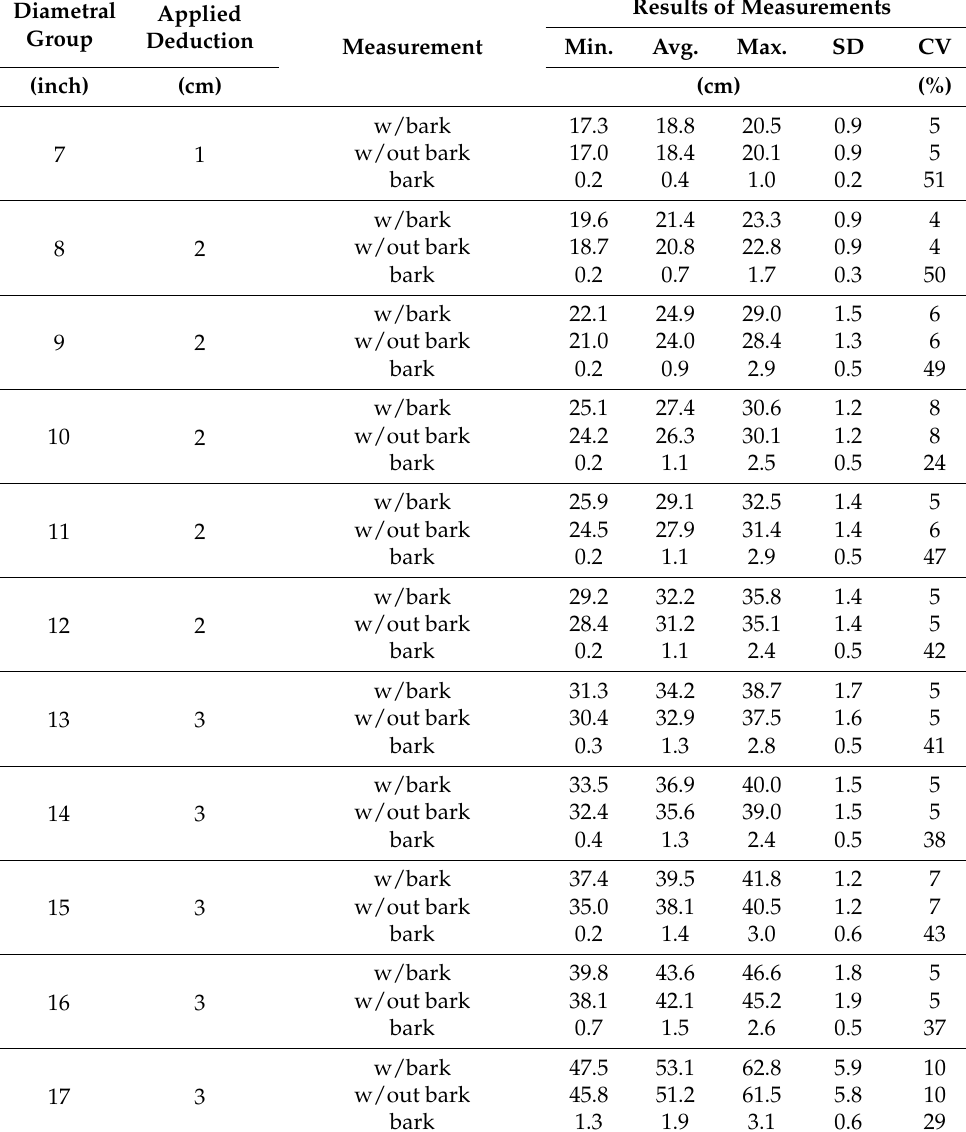
Table 3. The results of manual measurements of